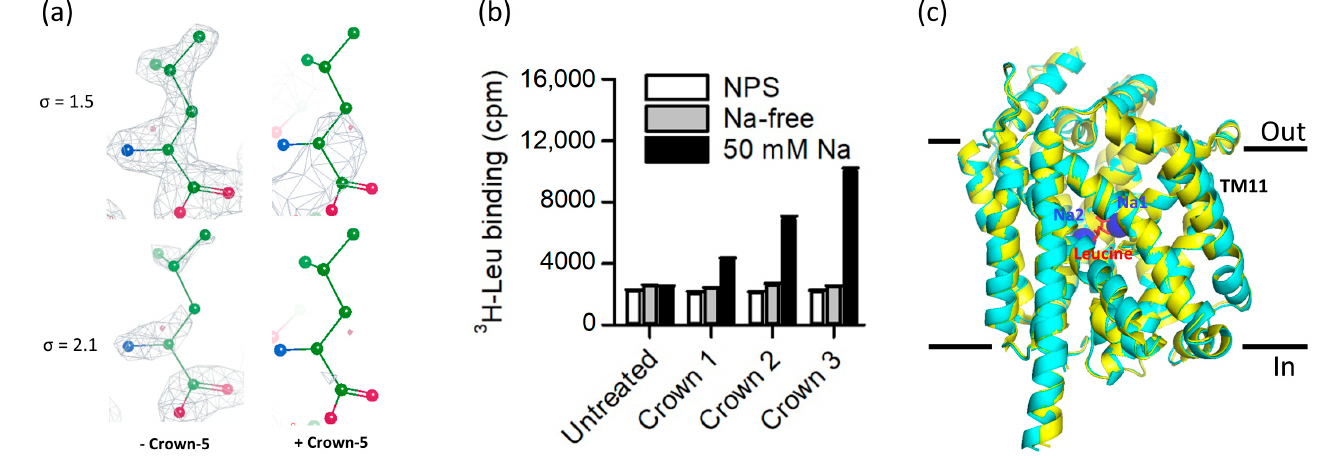
Figure 4. Na + and leucine depletion in LeuT. ( a ) 2Fo-Fc electron density maps of bound substrate leucine with and without Crown-5 soaking. ( b ) Removal of Na + from LeuT-containing E. coli C41(DE3) membrane vesicles by repeated treatments with Crown-5 as described in the Methods. The activity of 50 ng of purified LeuT from differently treated vesicles was then assessed by measuring the binding of 50 nM 3 H-Leu (120 Ci/mmol) in the presence of 50 mM NaCl (50 mM Na; black bars) or the absence of NaCl (Na-free; gray bars) in the assay buffer using the scintillation proximity assay (SPA). The non-proximity signal (NPS) was determined for each condition. Na + and Leu from the cell culture medium are trapped in LeuT and prevent significant binding of 3 H-Leu to the untreated sample. Repeated treatments with Crown-5 during the vesicle preparation led to the removal of the trapped compounds. Data are the mean ± S.E.M of three independent repeats that were performed as technical triplicates. ( c ) Comparison of LeuT structure with (yellow) and without (cyan) Crown-5 soaking (PDB code: 3GJD). Two Na + and the substrate leucine in the non-soaking structure (PDB code 3GJD) are shown as blue spheres and red sticks, respectively.